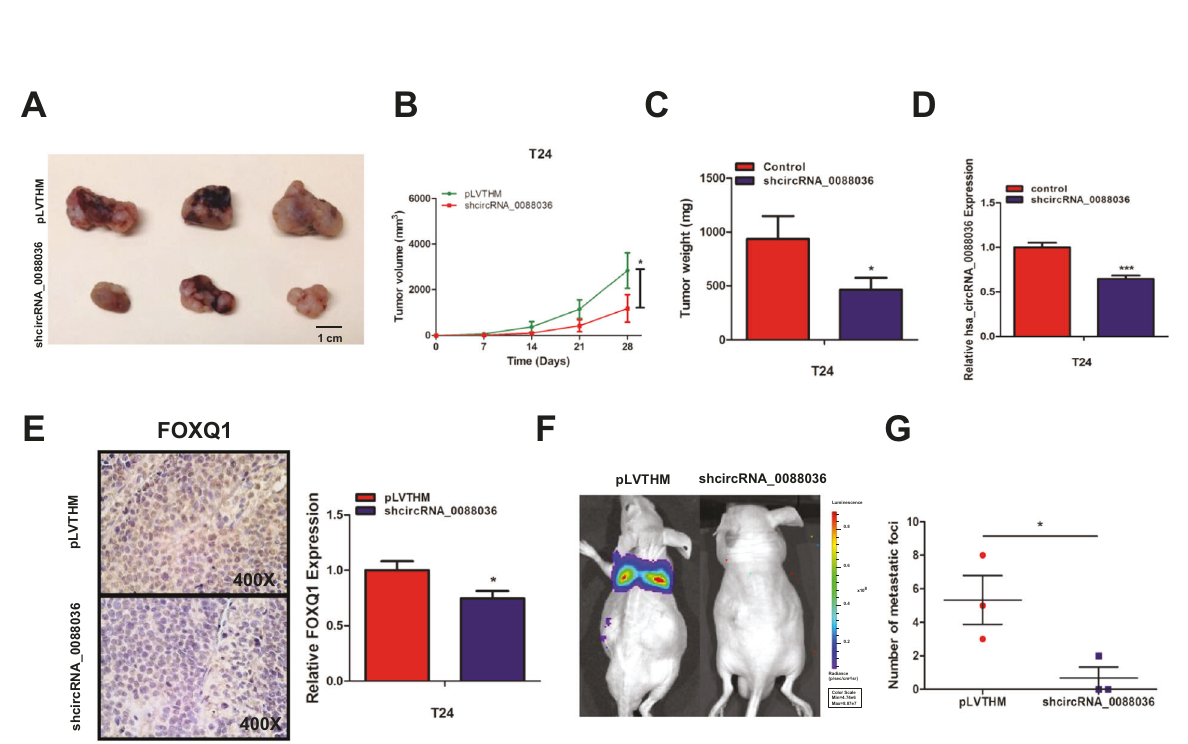
Fig. 5 Hsa_circRNA_0088036 promotes the proliferation, migration, and invasion of BCa cells by altering miR-140-3p-FOXQ1 signals. A Protein levels of FOXQ1 in T24 cells were determined by western blot analysis after co-transfection with shhsa_circRNA_0088036 and an miR-140-3p inhibitor. B Protein levels of FOXQ1 in UMUC3 cells were determined by western blot analysis after co-transfection with oehsa_circRNA_0088036 and miR-140-3p mimics. C The addition of an miR-140-3p inhibitor partially rescued the growth of T24 cells transfected with shhsa_circRNA_0088036, as determined by the cell proliferation assay. D The addition of miR-140-3p mimics partially rescued the growth of UMUC3 cells transfected with oehsa_circRNA_0088036, as determined by the cell proliferation assay. E Wound healing assays were performed using four groups of T24 cells (pLVTHM + NC, shhsa_circRNA_0088036, shmiR-140-3p, and shhsa_circRNA_0088036 + shmiR- 140-3p). F Wound healing assays were performed using four groups of UMUC3 cells (pLVTHM + pWPI, oehsa_circRNA_0088036, oemiR-140-3p, and oehsa_circRNA_0088036 + oemiR-140-3p). G Transwell invasion assays were performed using four groups of T24 cells (pLVTHM + NC, shhsa_circRNA_0088036, shmiR-140-3p, and shhsa_circRNA_0088036 + shmiR-140-3p). 100 μ L matrigel was added into upper chambers. The invading cells were counted in 10 randomly chosen microscopic fi elds (100×) of each experiment and pooled. H Transwell invasion assays were performed using four groups of UMUC3 cells (pLVTHM + pWPI, oehsa_circRNA_0088036, oemiR-140-3p, and oehsa_circRNA_0088036 + oemiR-140-3p). 100 μ L matrigel was added into upper chambers. The invading cells were counted in 10 randomly chosen microscopic fi elds (100×) of each experiment and pooled. I A schematic diagram indicating that hsa_circRNA_0088036 promoted the proliferation of BCa cells through miR-140-3p/FOXQ1 signaling.